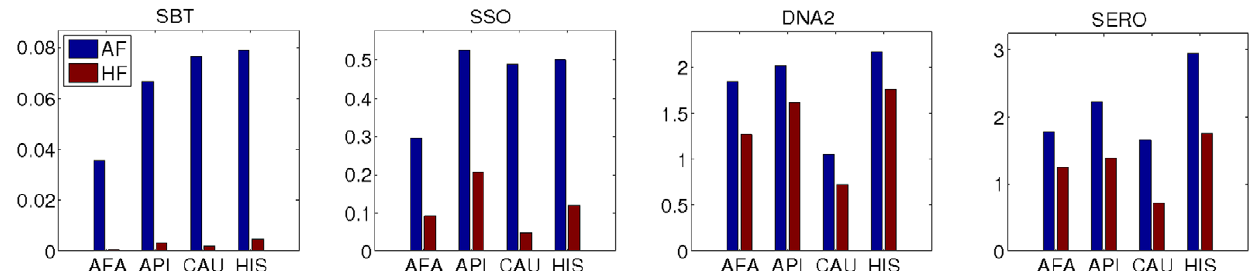
Figure 3. Comparison of average per-locus entropies obtained from allele and haplotype frequencies. This figure shows the comparison between allele entropy and haplotype entropy computed for four typing methods: SBT (single pass sequence-based typing), SSO (sequence-specific oligonucleotides), DNA2 (two-digit allele family level DNA-based typing) and SERO (serological typing), respectively from left to right. Allele entropy was computed using allele frequencies (AF) and genotype entropy was computed using haplotype frequencies (HF). The y-axis shows the average entropy values, and the x-axis shows the four continental populations for which the entropy was computed: AFA (African American), API (Asian-Pacific Islander), CAU (Caucasian) and HIS (Hispanic), respectively. In all figures, the locus entropy is averaged across the three loci, HLA-A, -B, -DRB1.